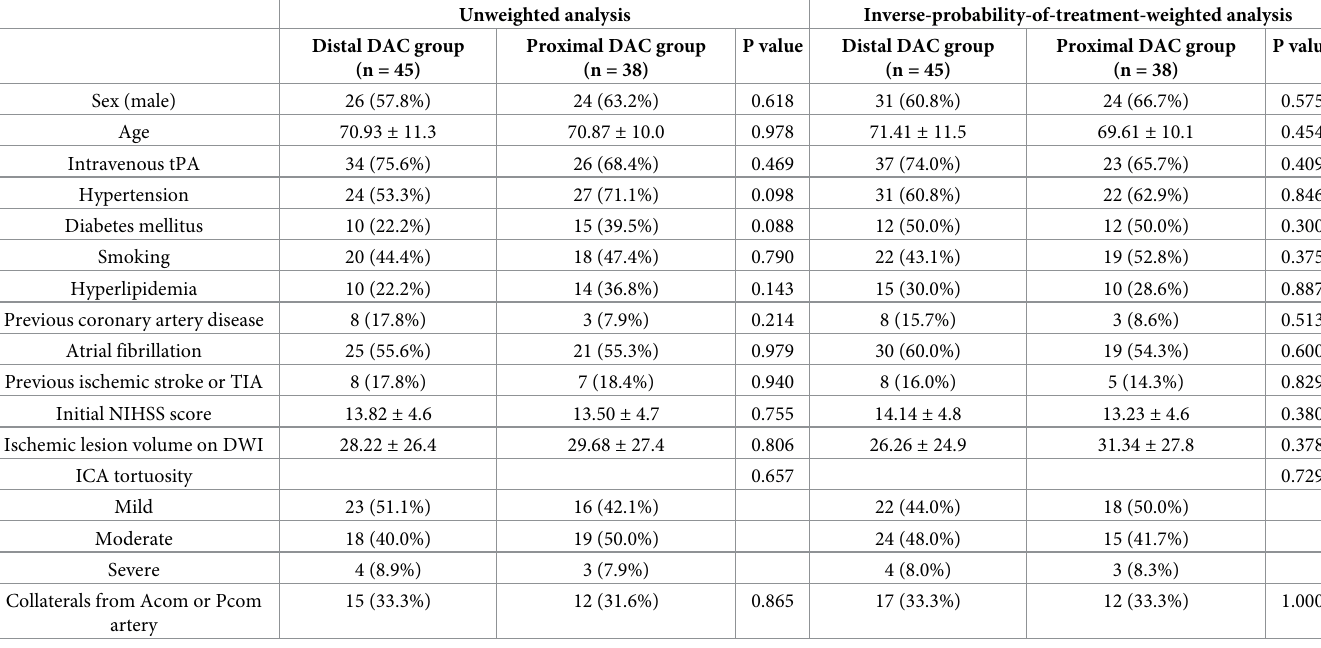
Table 1. Comparison of the baseline characteristics according to the DAC tip